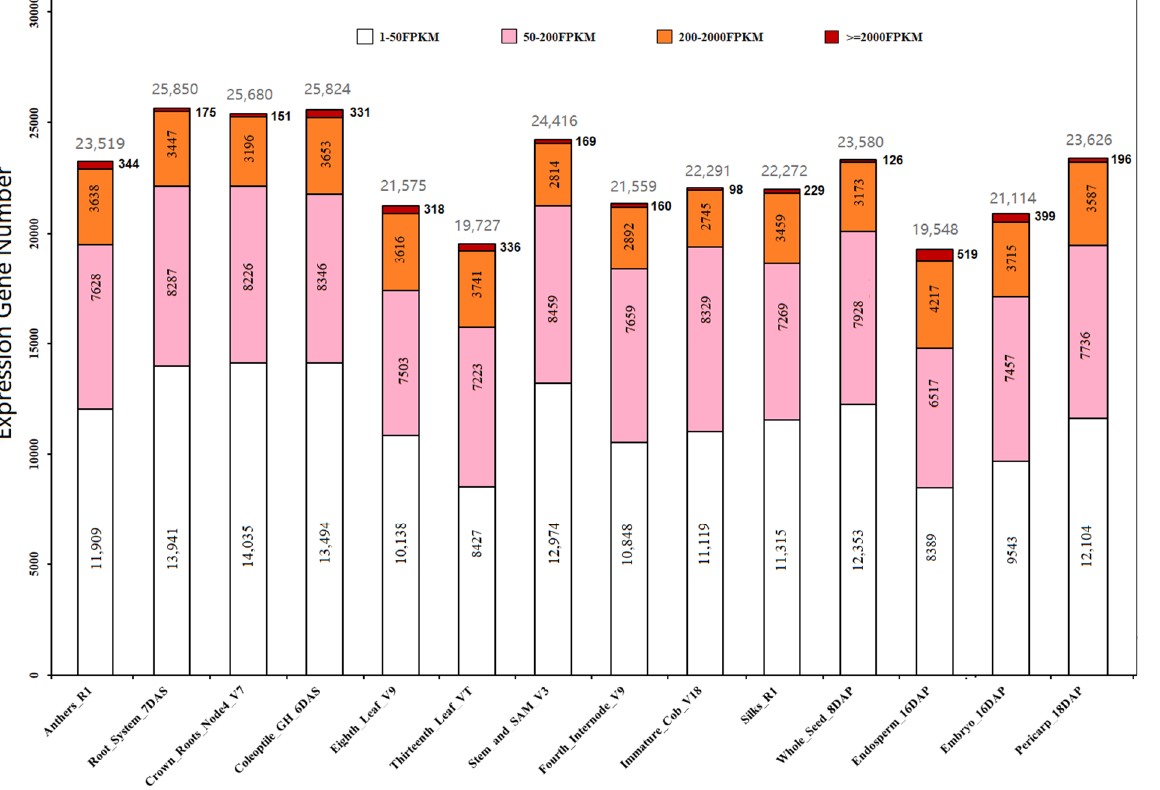
Figure 3. Unique transcripts identified in 14 maize tissue types and grouped according to their abundance. Very highly expressed genes (VHEG), highly expressed genes (HEG), medium expressed genes (MEG), and low expressed genes (LEG) are indicated in dark red, orange, pink and white color, respectively, in the columns. VHEG, HEG, MEG, and LEG possess the transcript levels of ≥2000, 200–2000, 50–200, and 1–50 FPKM, respectively. The total EG number of each tissue was indicated on the top of the columns in grey color. The transcriptome profiling data of 14 selected tissues were extracted from the transcriptome profiling dataset [70,73].